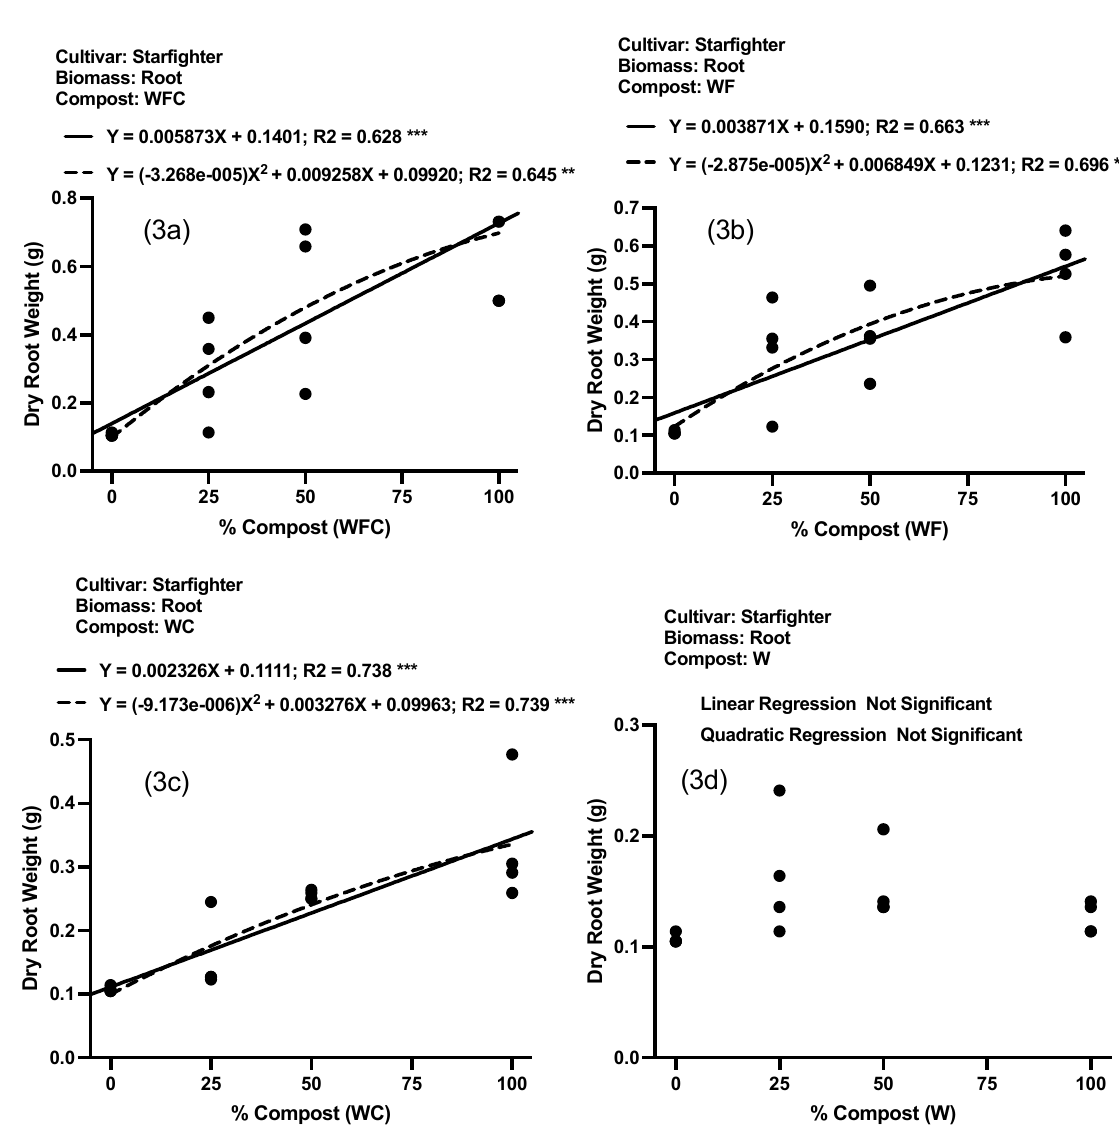
Figure 3. Effect of the percent of compost in growing media on the dry root biomass of cv. Starfighter: ( 3a ) Compost WFC; ( 3b ) Compost WF; ( 3c ) Compost WC; and ( 3d ) Compost. ** and *** significant at p < 0.01 and p < 0.001, respectively.